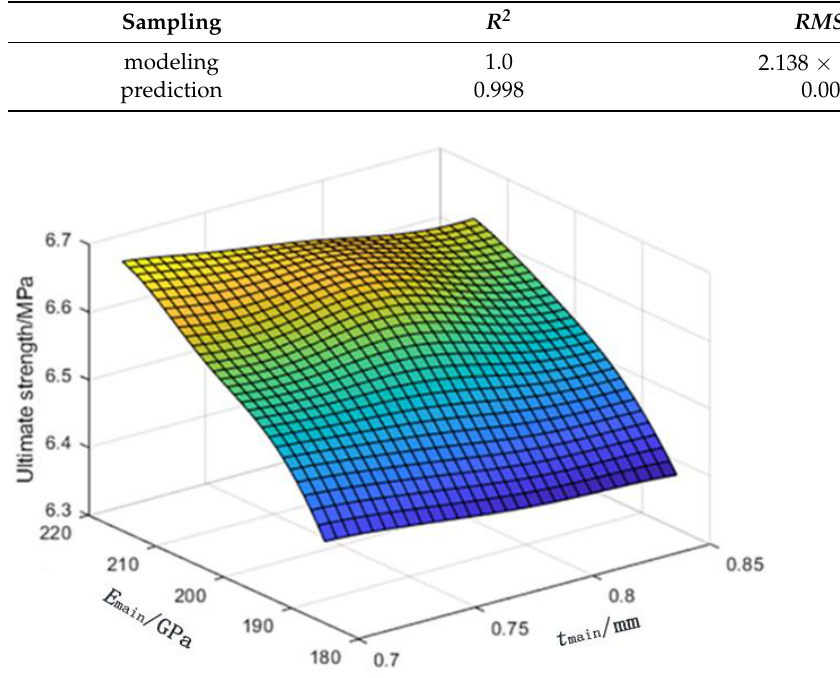
Figure 13. GP model between E main and t main , with ultimate strength.